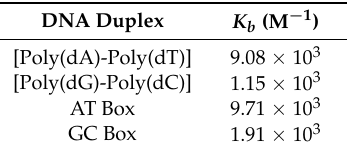
Table 2. K b values for compound 4a with various DNA